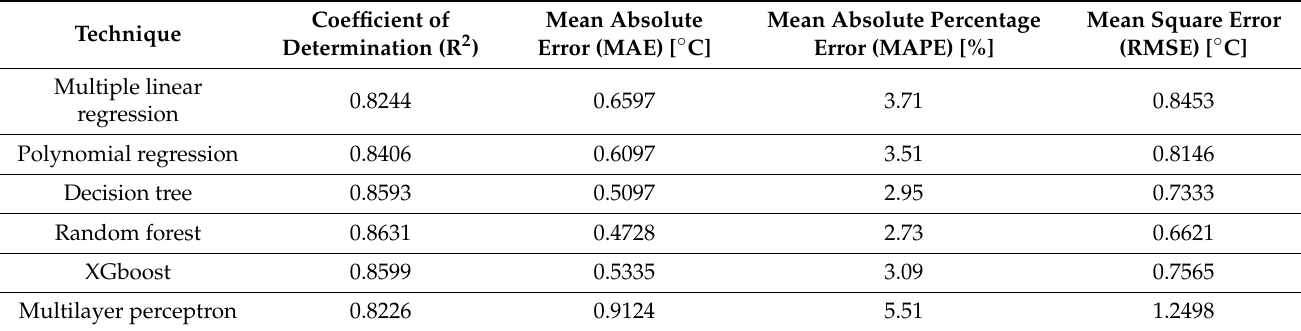
Table 7. Evaluation metrics for temperature